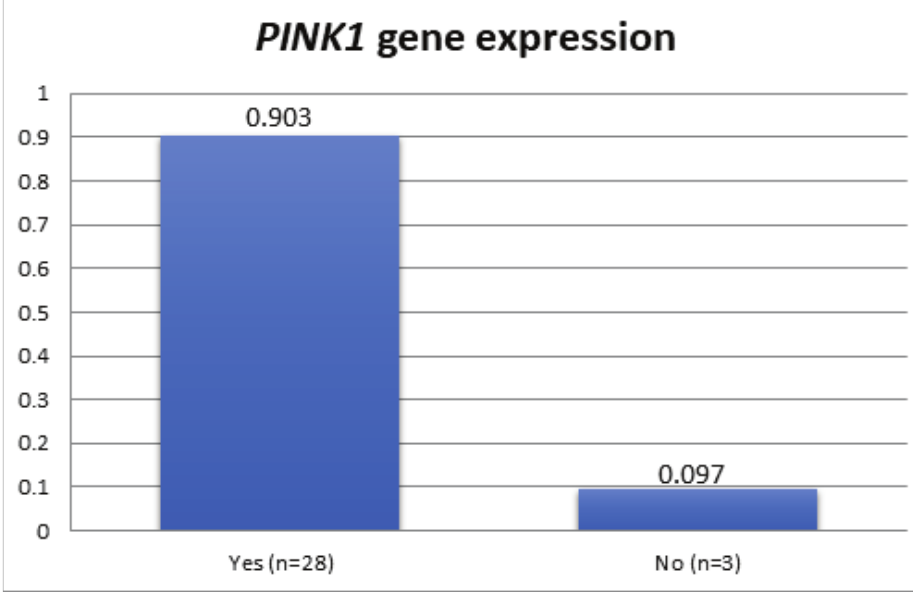
Figure 4: PINK1 gene expression distribution among the study group.